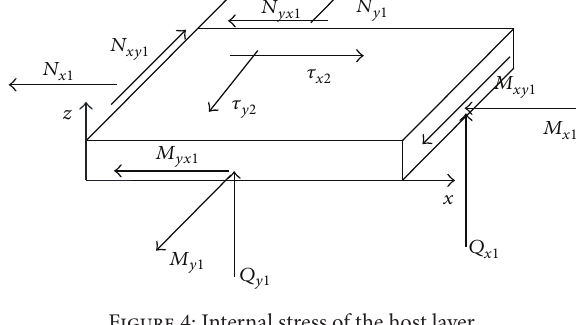
Figure 4: Internal stress of the host layer.